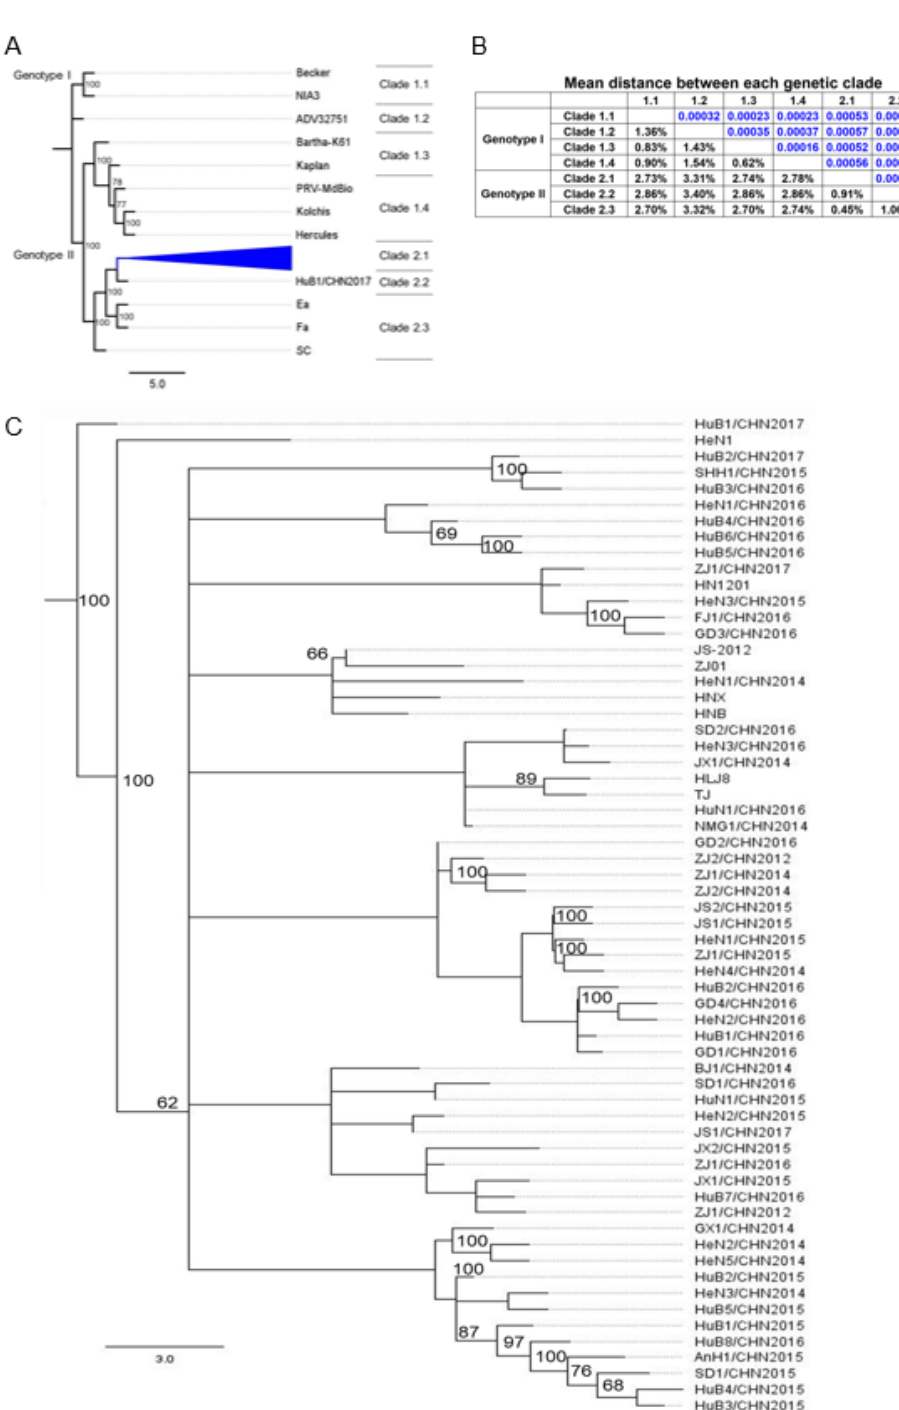
Figure 2. Phylogenetic relationship of PRV genome sequences. ( A ) A maximum likelihood (ML) tree was constructed by using MEGA X, based on the alignment of 73 PRV genome sequences (Tables S1 and S2). Gapped regions, which are labeled in Figure 1 within the multisequence alignment, were removed from all sequences before phylogenetic analysis. The ML tree is a rooted tree, and all branch lengths were drawn to a scale of nucleotide substitutions per site. Bootstrap resampling (100 replication) was performed. The branches of Genetic Clade 2.1 are collapsed. ( B )The mean distance between each genetic clade was calculated by MEGA X with the Jukes–Cantor model. ( C ) Expansion of the collapsed clade (Clade 2.1) in the panel A of this figure.